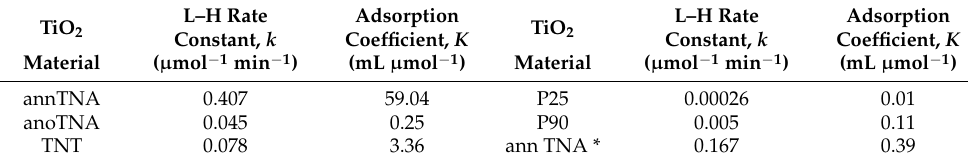
Adsorption Coefficient, K